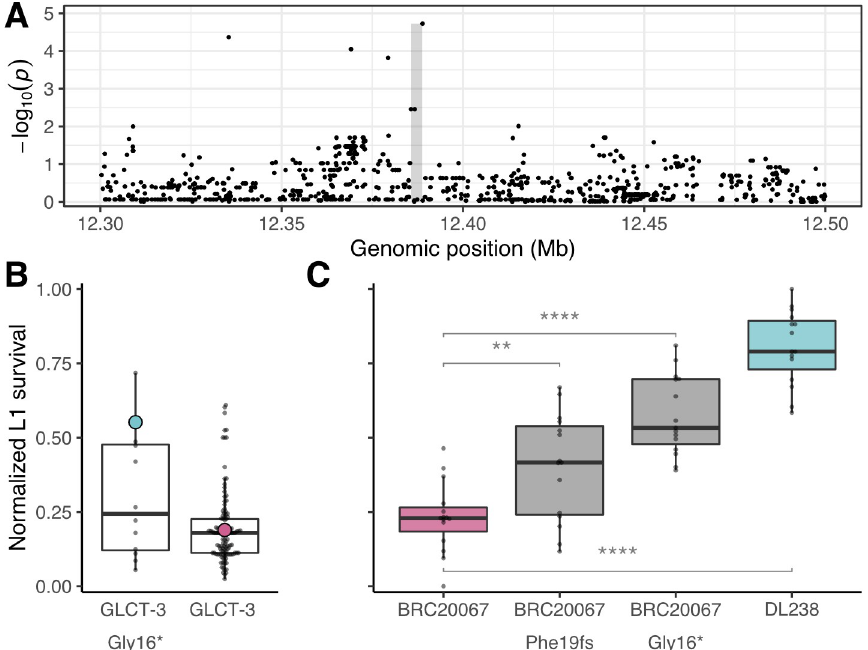
Fig 4. Variation in glct-3 underlies differential propionate sensitivity in C . elegans . (A) Manhattan plot showing the strength of correlation between variants surrounding the glct-3 gene identified by gene-based GWA mapping of the normalized L1 survival after propionate exposure phenotype. The gray shaded rectangle represents the glct-3 gene (chrI:12385765–12388791). (B) Tukey box plots of C . elegans wild isolate’s normalized L1 survival after exposure to 100 mM propionate. Each dot represents the mean of 20 replicate measures for each strain. Strains are separated by the presence of a stop-gained variant at amino acid position 16 of GLCT-3. DL238 (blue) and BRC20067 (pink) are highlighted for reference. (C) Tukey box plots of normalized L1 survival of each CRISPR-edited and parental strain after exposure to 100 mM propionate are shown. Each dot represents a replicate L1 survival measurement. (The effect of strain on phenotype data is significant from analysis of variance [F(3,56) = 45.081, p < 0.05E-10]. For individual strain comparisons: �� represents [F(1,28) = 9.28, p = 0.005] and ���� for the BRC20067 –BRC20067 (Gly16 � ) comparison [F(1,28) = 55.25992, p < 0.05E-6]) And for the BRC20067 –DL238 comparison [F(1,28) = 165.7699, p <